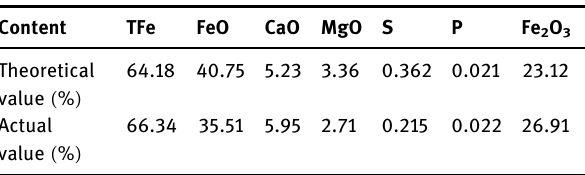
Table 12: Comparisonoftheoreticalandactualchemicalcomposition of the converter slagging agent Content